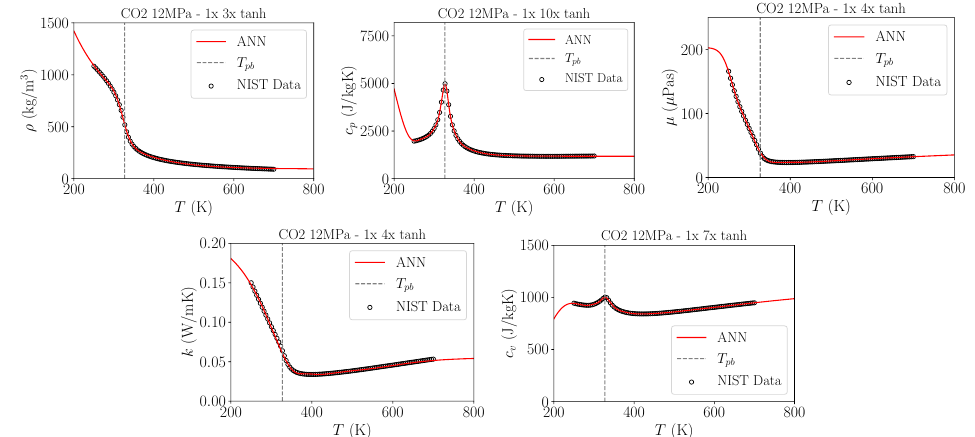
Figure 3. Comparison of NIST data and ANN fit of CO 2 properties. From top to bottom: density ρ , isobaric specific heat capacity c p , viscosity µ , thermal conductivity k , and isochoric specific heat capacity c v . From left to right: p = 10,12,20 MPa. The ANN was fit for T = 250,700 K, data { } { } are shown to 200 K to demonstrate ANN behavior outside of the fitted interval. The pseudo boiling temperature T pb at which c p reaches a maximum increases with rising pressure. From